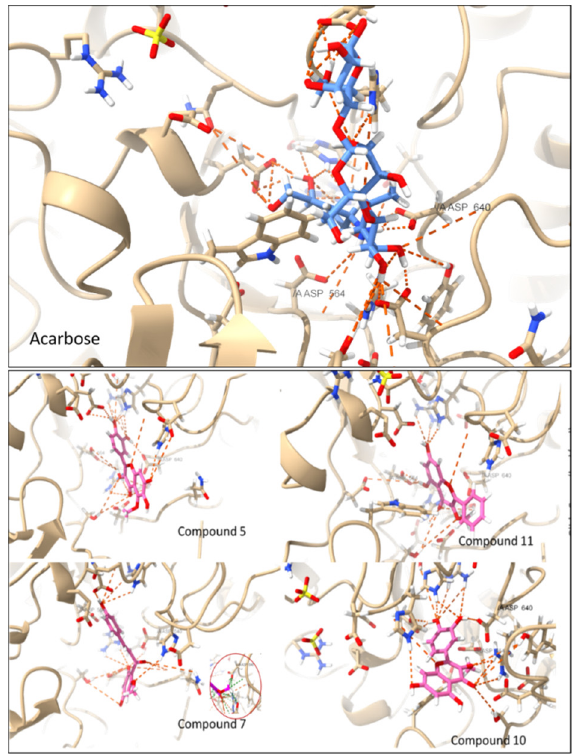
Figure 4. Active site amino acid residue interaction analysis of the acarbose (top panel) and the top docked poses of compounds 5 , 7 , 10 , 11 with alpha-glucosidase. Compound 5 showed 20 hydrogen bond interactions with active site residues (including catalytic nucleophile Asp564 and acid/base catalyst Asp640 amino acid residues) while compounds 10 and 11 showed 16 and 11 hydrogen bond interactions respectively with active site residues. Compound 7 showed 14 hydrogen bond interactions (no hydrogen bond interactions with the catalytic nucleophile Asp564 and acid/base catalyst Asp640 amino acid residues but three Van der Waals interactions with